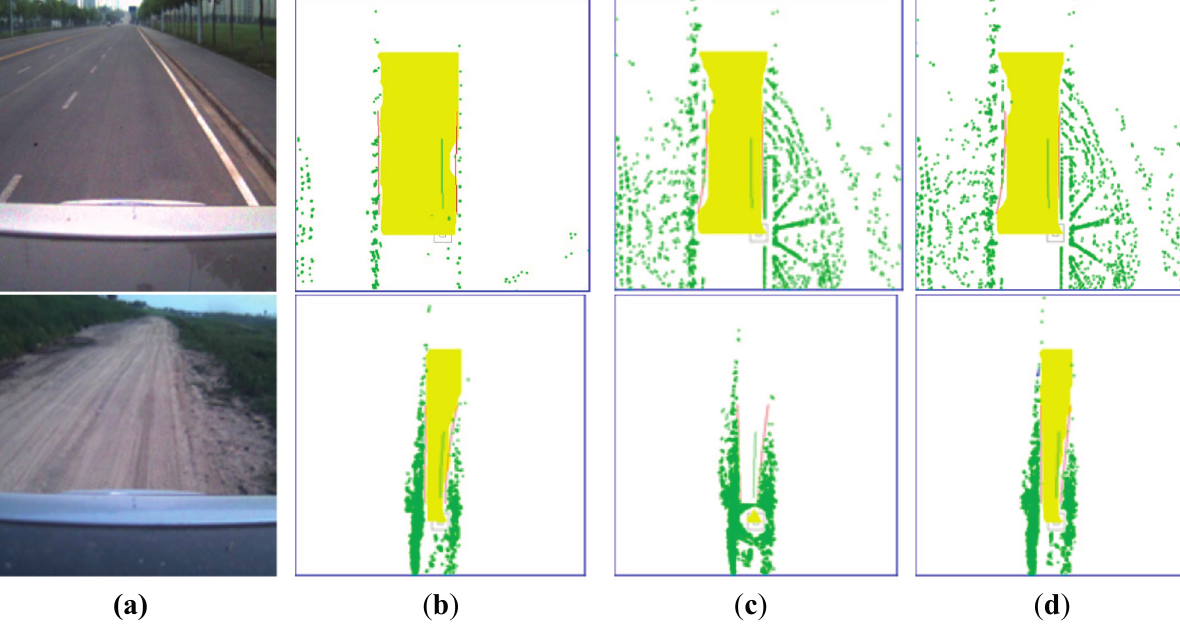
Figure 9. Comparison between multi-feature road surface segmentation and segmentation based on height difference. Left to right columns: ( a ) Original image taken by a camera; ( b ) Image resulting from the height difference feature with a strict threshold; ( c ) Image resulting from the height difference feature with a loose threshold; ( d ) Image resulting from the multi-feature scheme with a loose